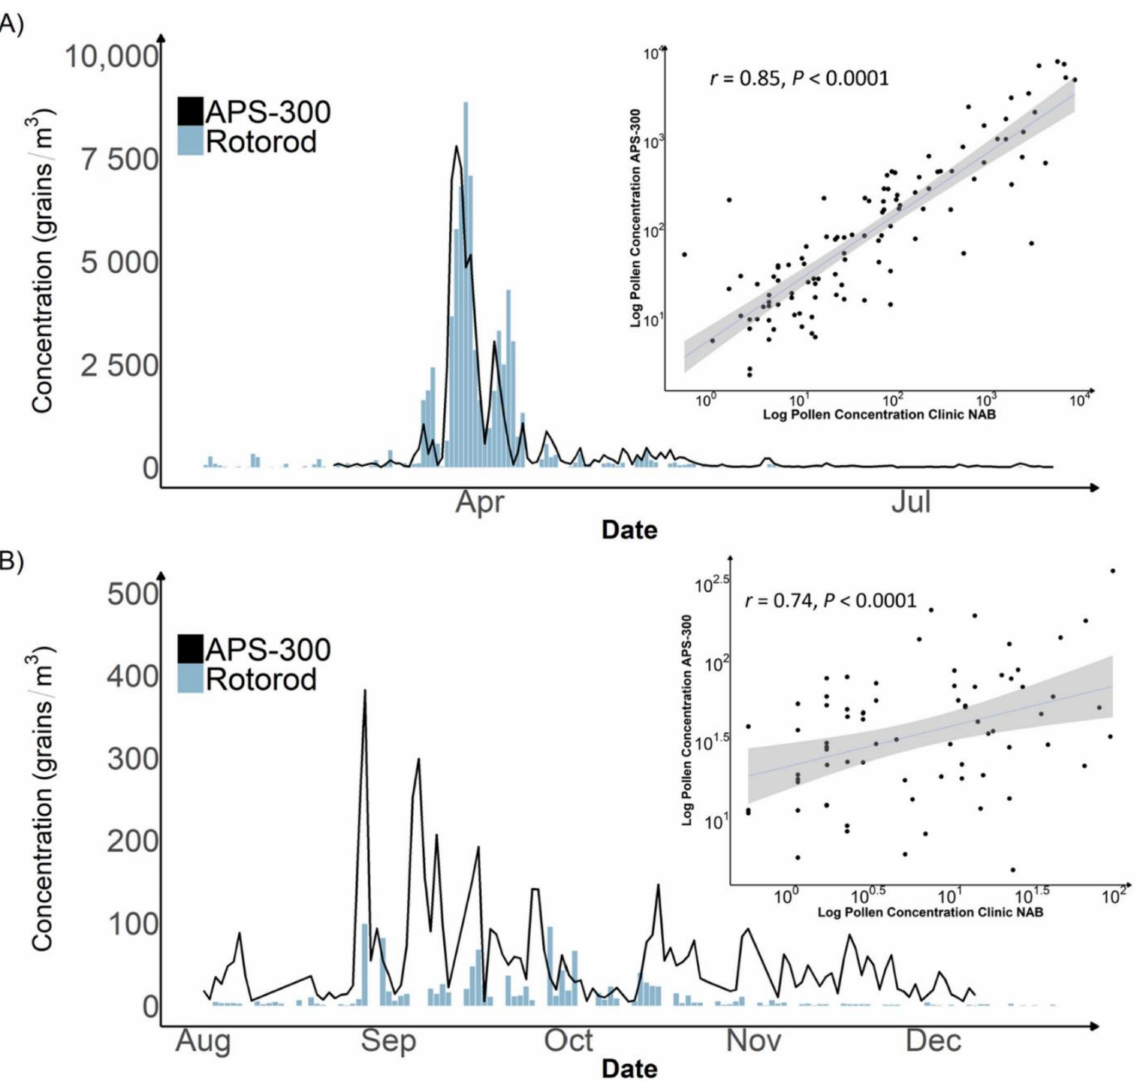
Figure 2. Time Series Plot and Scatter Plot of Daily Pollen Concentration Measured by Rotorod sampler with manual counting vs. APS-300 in Marietta, Atlanta, 2020. Plot ( A ) displays a time series plot of the peak pollen season with a Pearson correlation plot. Plot ( B ) displays a time series plot of the off-peak pollen season with a Pearson correlation